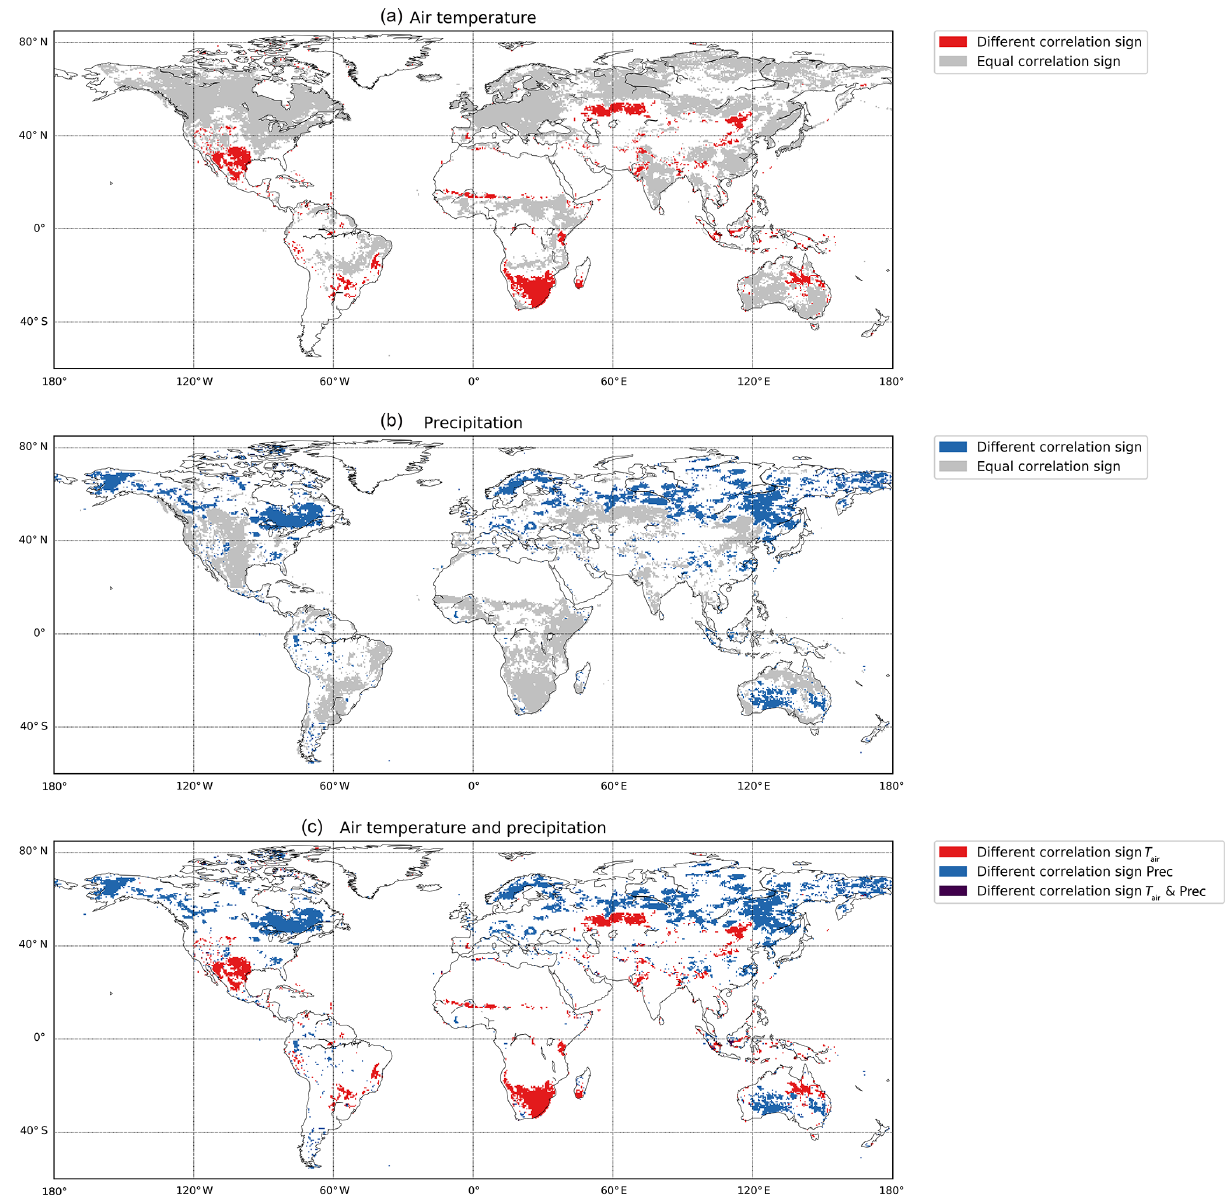
Figure 4. Global comparison of differences in the sign of the correlation between the annual and long-term scale for NDVI and air temper- ature (a) , NDVI and precipitation (b) , and summary of both (c) . Areas in which the sign of the correlation is inverted between seasonal and longer-term scales are highlighted in color, and areas where the sign of the correlation is identical between scales are highlighted in gray (a, b) . Areas with correlations between − 0 . 2 and 0 . 2 were not